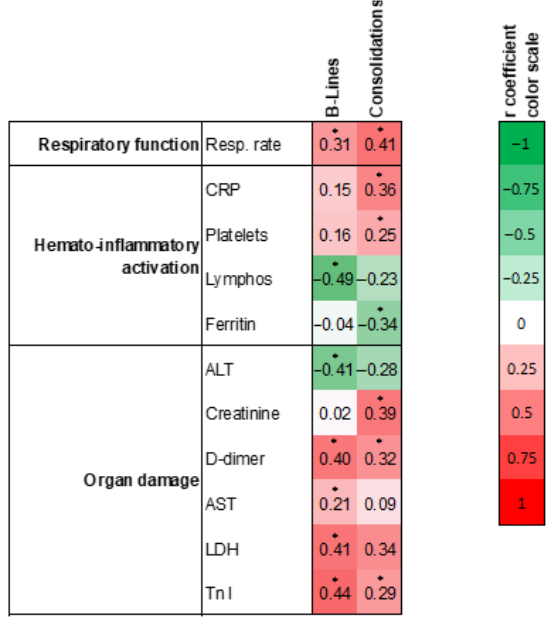
Figure 3. LUS scores and clinical-laboratory parameters. Clinical and laboratory parameters were divided into those re- lated to respiratory function, hemato-inflammatory activation, and end-organ damage. Numbers indicate regression co- efficients and * indicate statistical significance ( p < 0.05). The color code shown on the right reflects sign and degree of the correlation. CRP; C-reactive protein; ALT: alanine aminotransferase; AST: aspartate aminotransferase; LDH: lactate dehy- drogenase; Tnl: Troponin